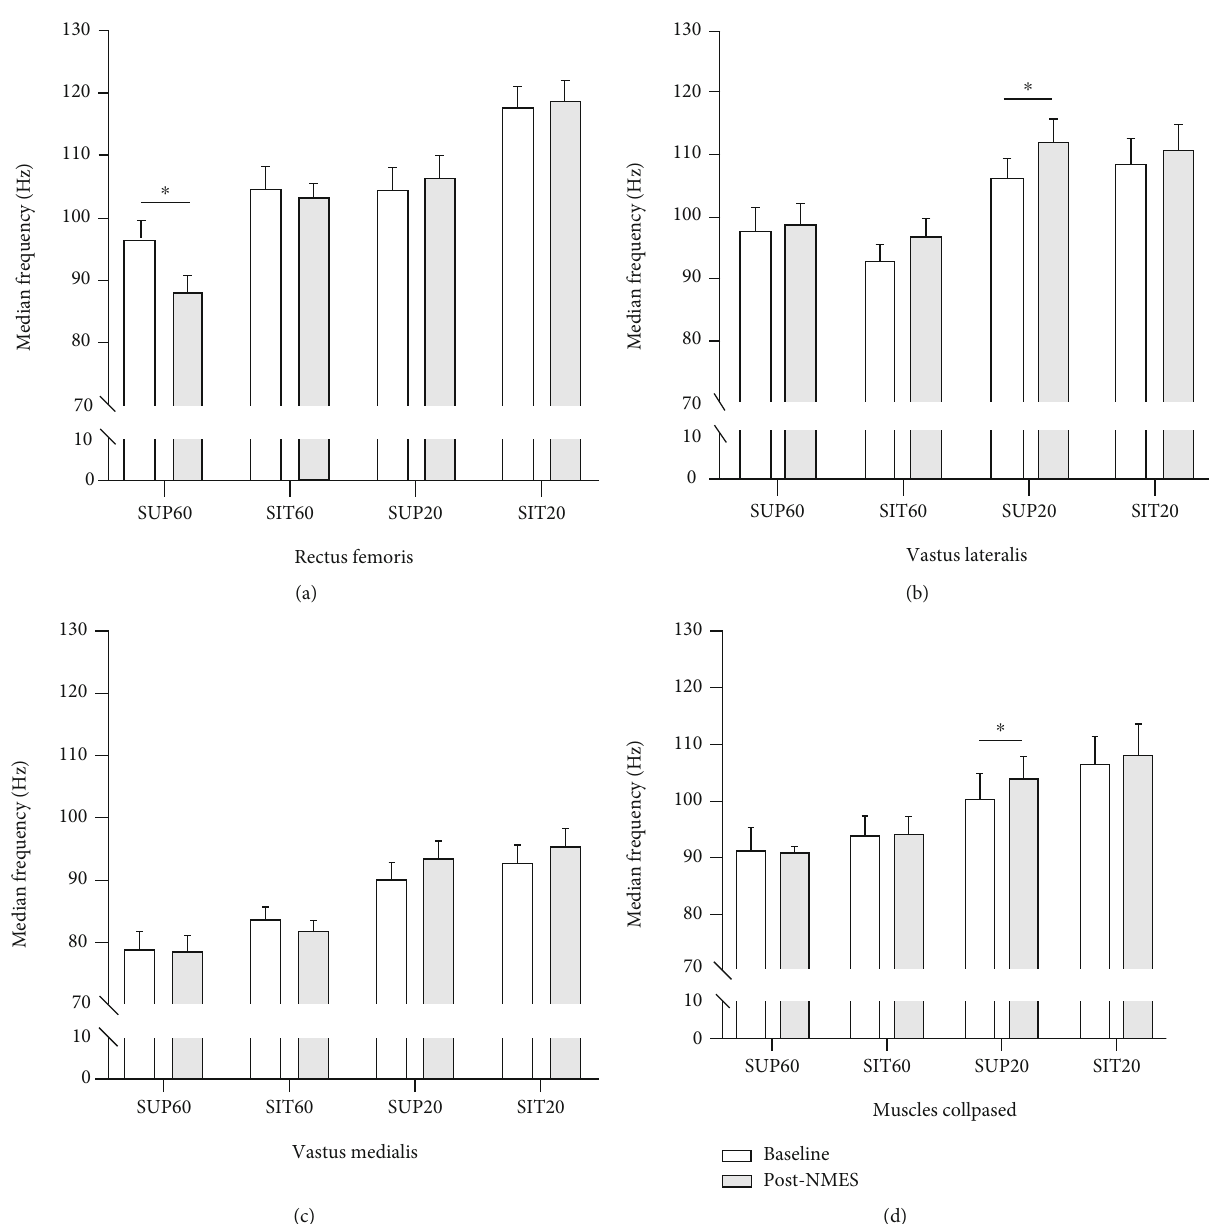
Figure 4: Median frequency pre- (baseline) and post-NMES for quadriceps constituents individually and grouped. Data are presented as mean and 95% CI. Abbreviations: SUP60: supine with knee fl exed at 60 ° ; SIT60: seated with knee fl exed at 60 ° ; SUP20: supine with knee fl exed at 20 ° ; SIT20: seated with knee fl exed at 20 ° . NMES: neuromuscular electrical stimulation. Statistically signi fi cant di ff erences: ∗ p < 0 : 05 vs.